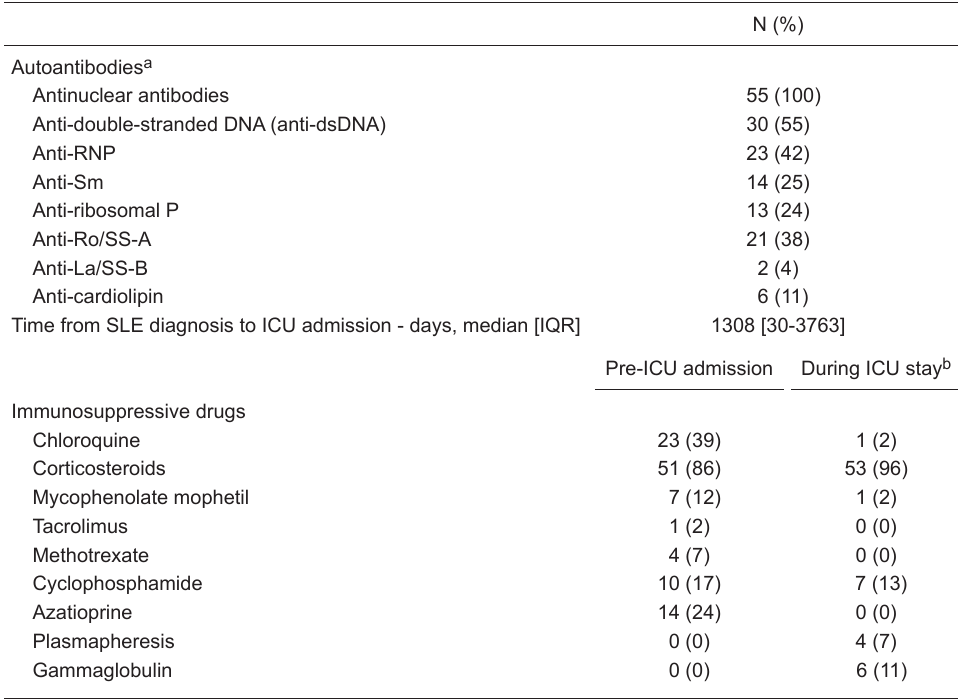
Table 2. Characteristics of patients with systemic lupus